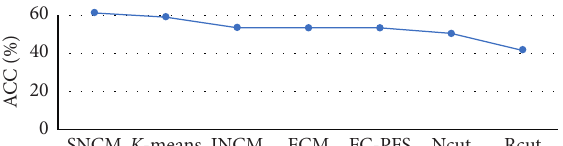
Figure 3: The average accuracy of the algorithm.